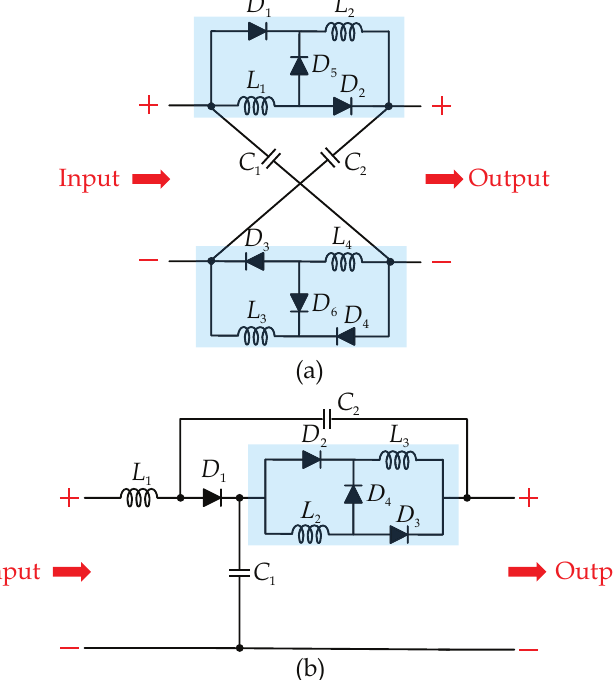
Figure 2. Modified impedance networks based on switched-inductor: ( a ) switched-inductor Z-source inverter [8], and ( b ) switched-inductor quasi-Z-source inverter